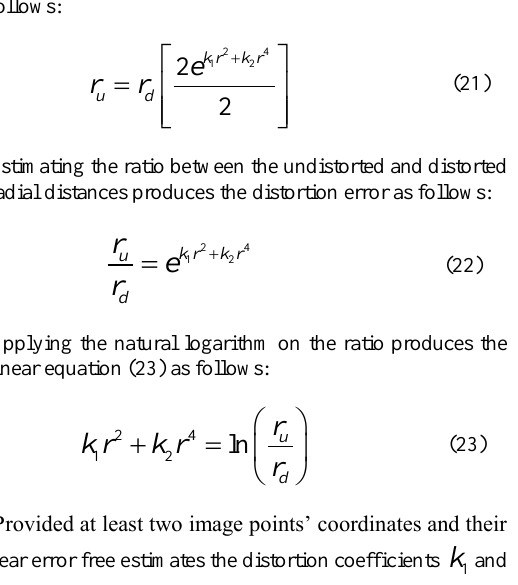
Figure 2: Variation of distortion coefficient